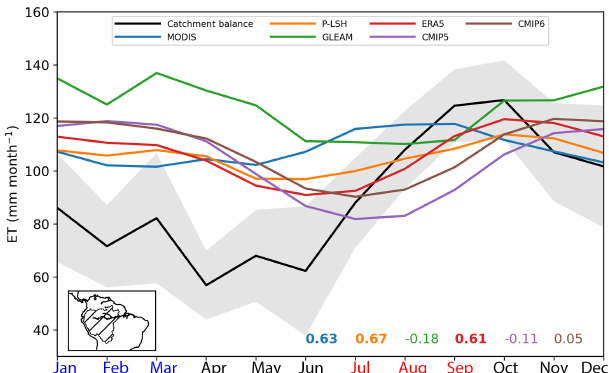
Figure 6. Climatological seasonal cycles in evapotranspiration (ET) over the Amazon. Mean seasonal cycle in ET from catchment bal- ance, satellites (MODIS, P-LSH, and GLEAM), ERA5 reanalysis, and climate models (CMIP5 and CMIP6) over the Amazon region drained by Óbidos (region indicated in the inset map). Shading rep- resents the monthly standard deviation of the mean. Correlations with catchment-balance ET are shown, with bold numbers indicat- ing statistical significance ( p < 0 . 05). Data are from 2003 to 2013 with the exception of CMIP5, for which data are from 1994 to 2004. On the x axis, the three wettest months are indicated in blue and three driest months are indicated in red. Note that the y axis does not start at